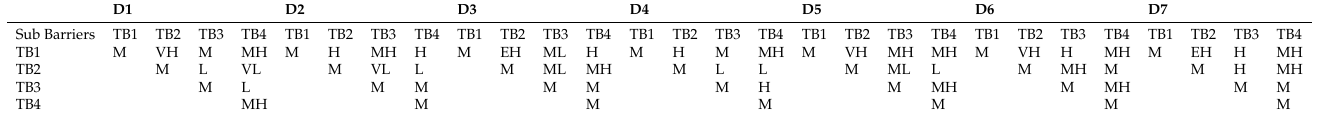
Table A4. The DMs judgments for the technological and system sub-barriers using linguistic variables.